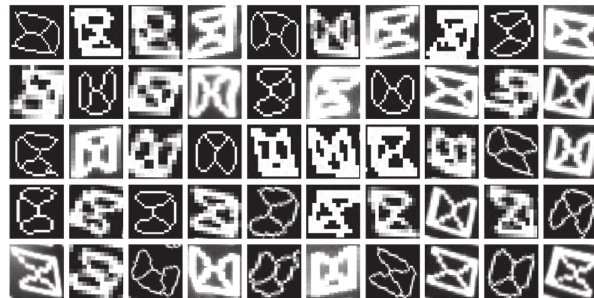
Figure 6: Sample images showing pattern elements with blur and